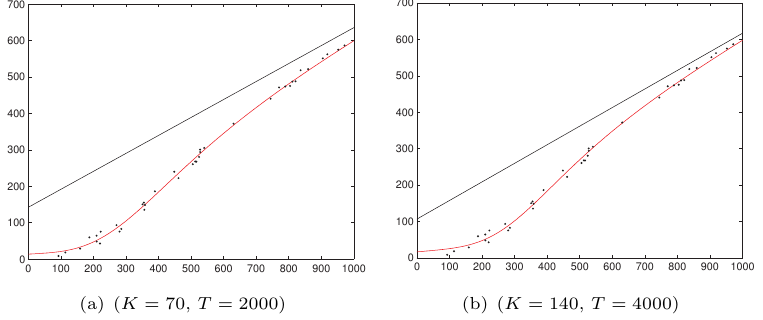
Figure 3. Graphic representation of the synthetic data points { t k ,y k } K modified Michaelis–Menten model F M ( t ; p,q,θ ) = ( pt + q ) f M ( t ; θ ) and its asymptote m ( t ) = pt + q at the optimal solution ( p ∗ ,q ∗ ,θ ∗